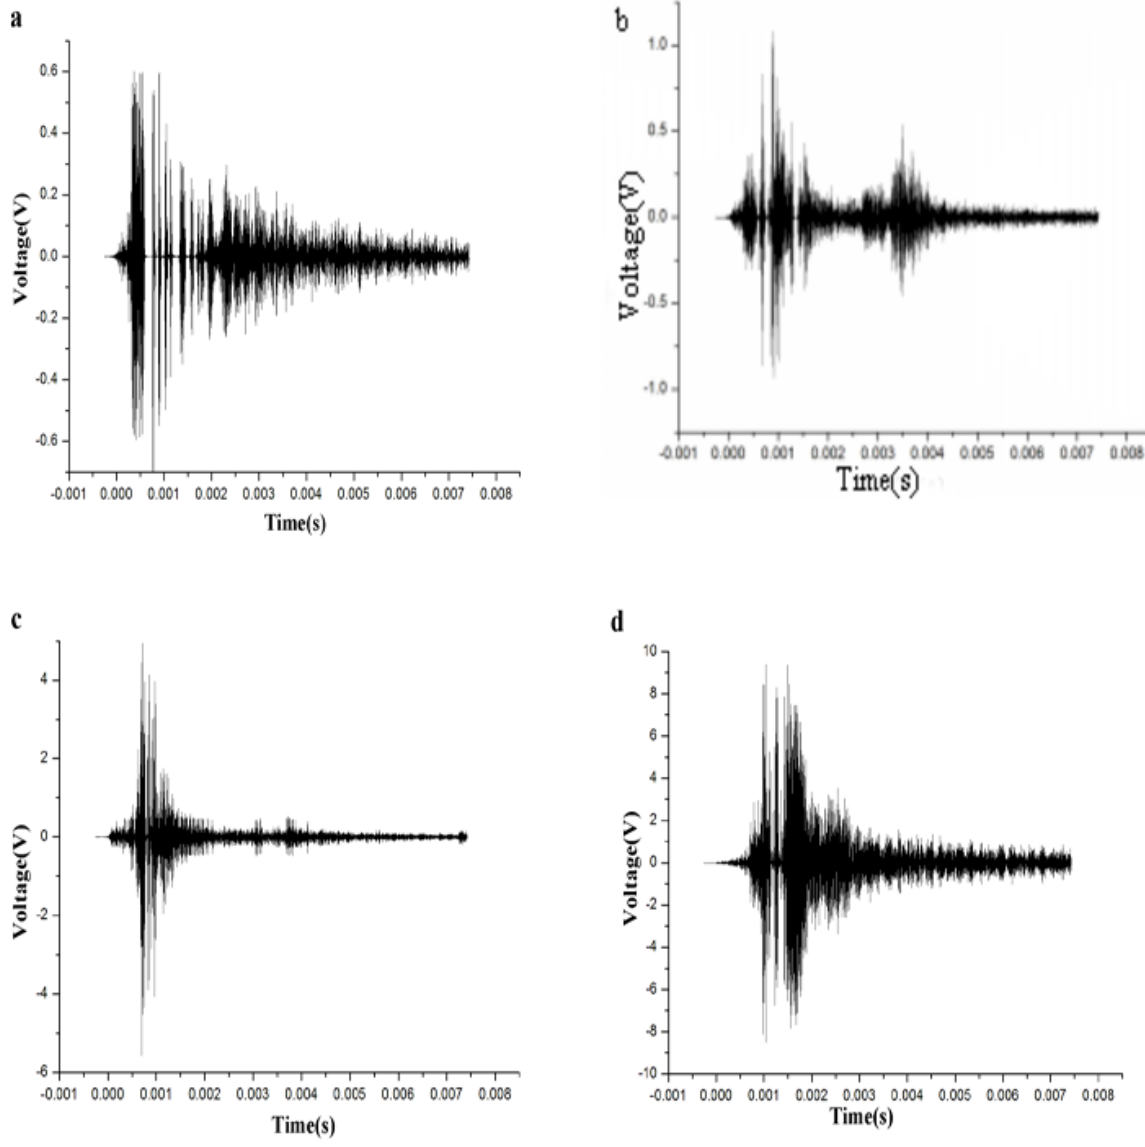
Figure 9: Spectrum analysis of coating: (a)Substrate; (b)NiCr coating; (c)Al 2 O 3 coating with the undercoating of NiCr; (d)Al 2 O 3